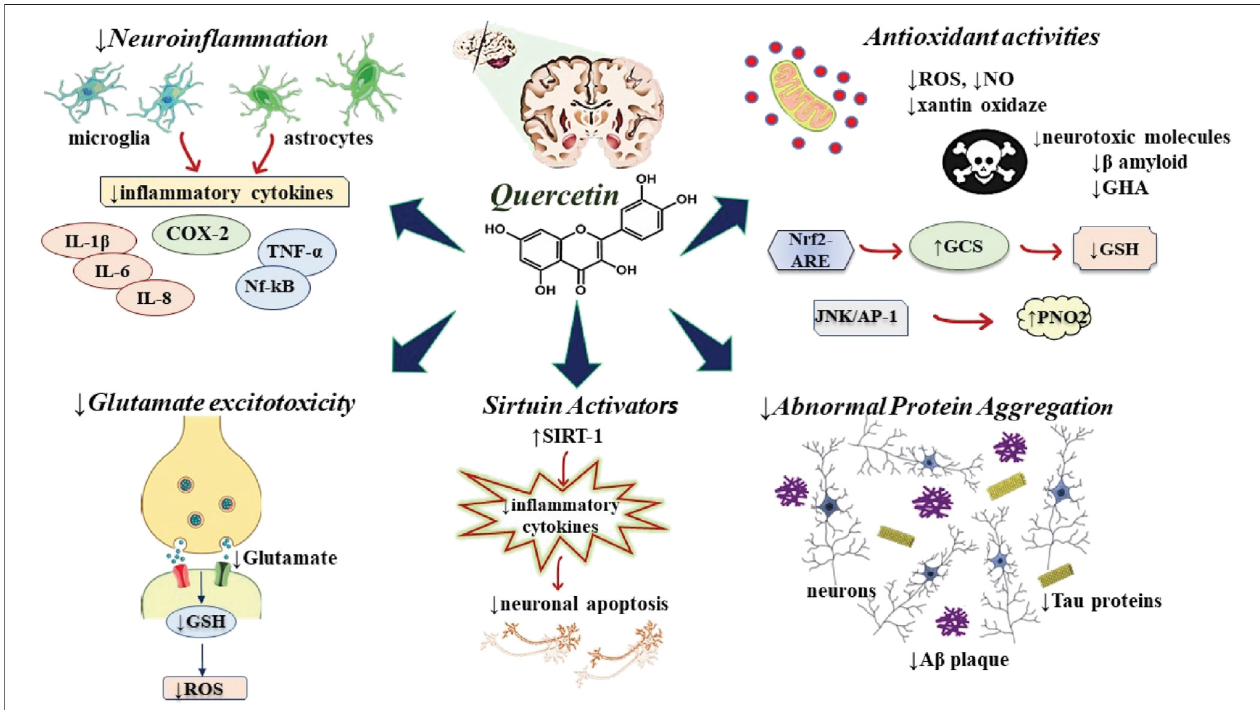
FIGURE 2 | Diagram with possible neuroprotective mechanisms of QUR. The fi gure highlights the neuronal neuroprotective action in various signaling pathways thatleadtothereleaseofproin fl ammatorycytokines,neurodegenerationandcellularapoptosis. Abbreviations: ↑ ,increase; ↓ ,decrease;A β ,amyloidbeta-peptide;GCS, γ -glutamyl-cysteine synthetase; GSH, glutathione; IL, interleukin; JNK, c-Jun N-terminal kinase; NO, nitric oxide; Nrf2-ARE, Nuclear factor erythroid-derived 2-like 2- antioxidant responsive element; PNO2, paraoxygenase 2; ROS, reactive oxygen species; SIRT1, sirtuin 1; TNF- α , tumor necrosis factor-alfa.